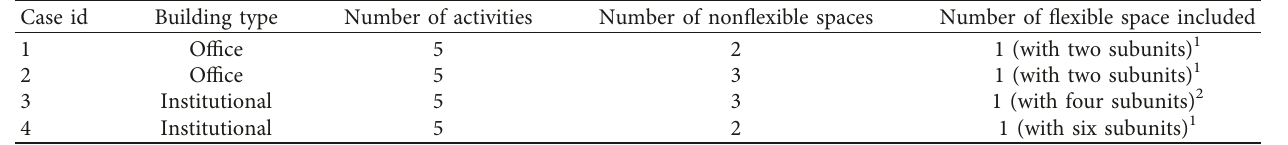
Table 3: Cases for validation of the